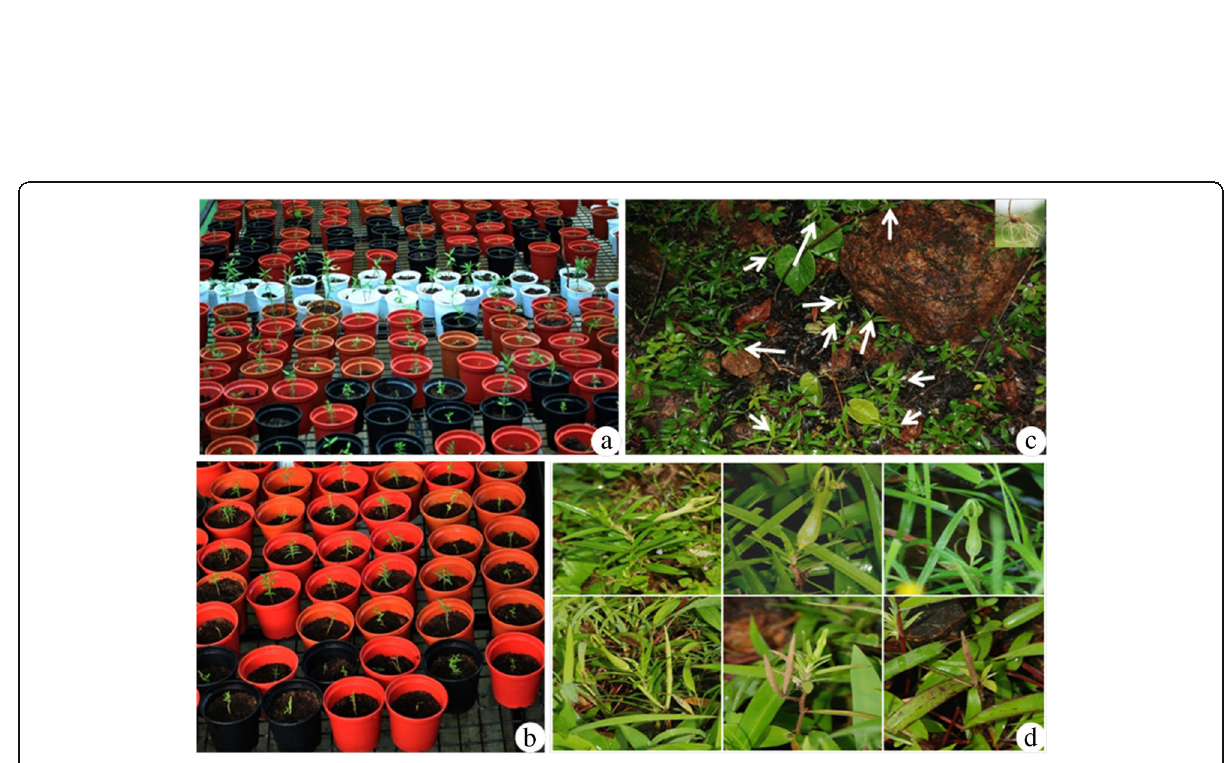
Fig. 2 Reintroduction of micropropagated plantlets into natural localities. a , b Large-scale hardening. c Reintroduced plantlets. d Regeneration in natural